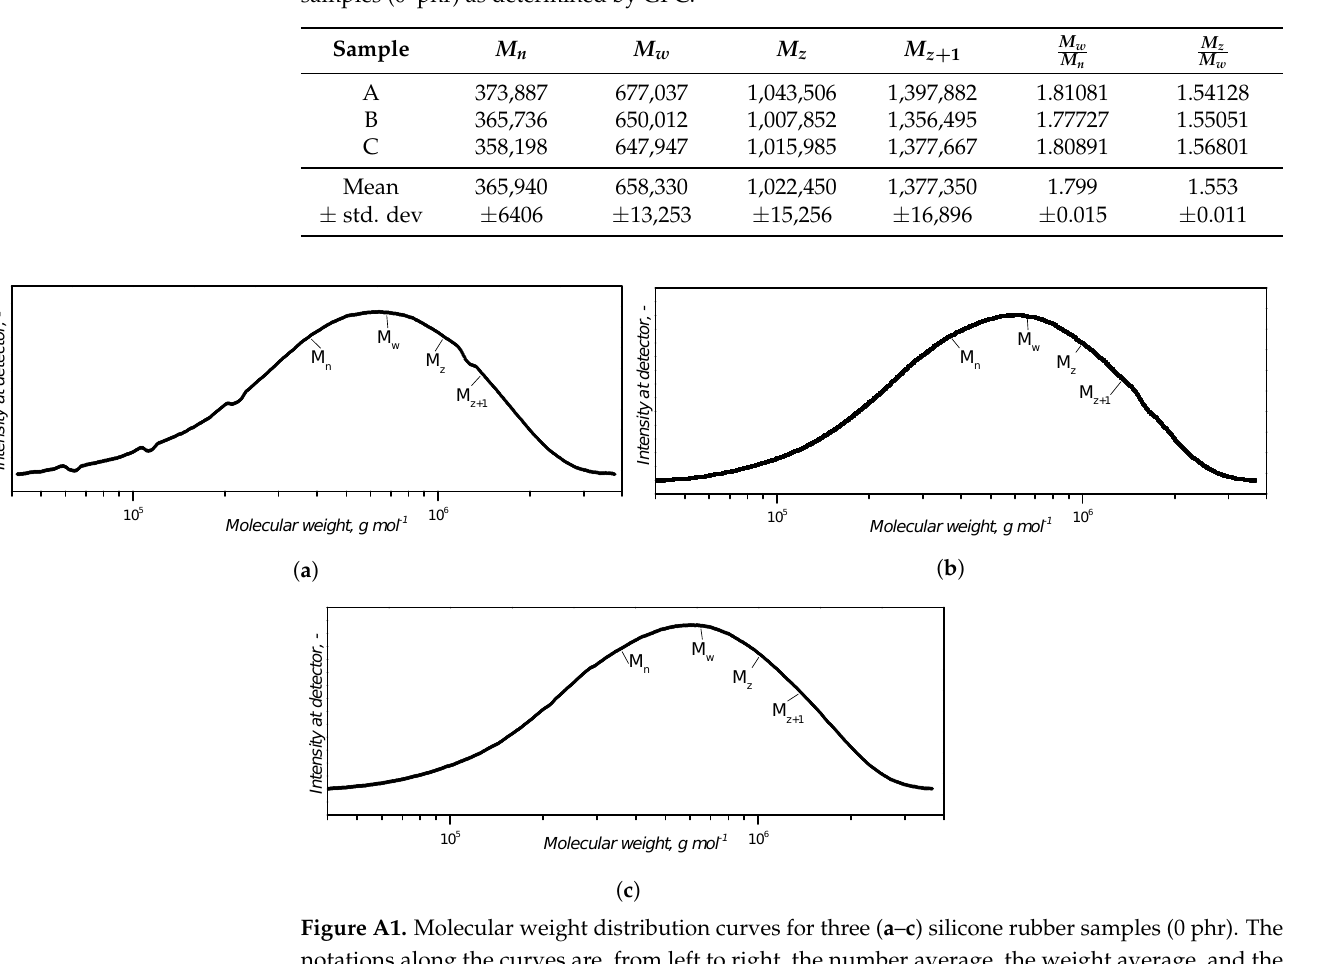
Table A1. Averaged molecular weights (g mol − 1 ) and polydispersity indexes for three silicone rubber samples (0 phr) as determined by GPC.